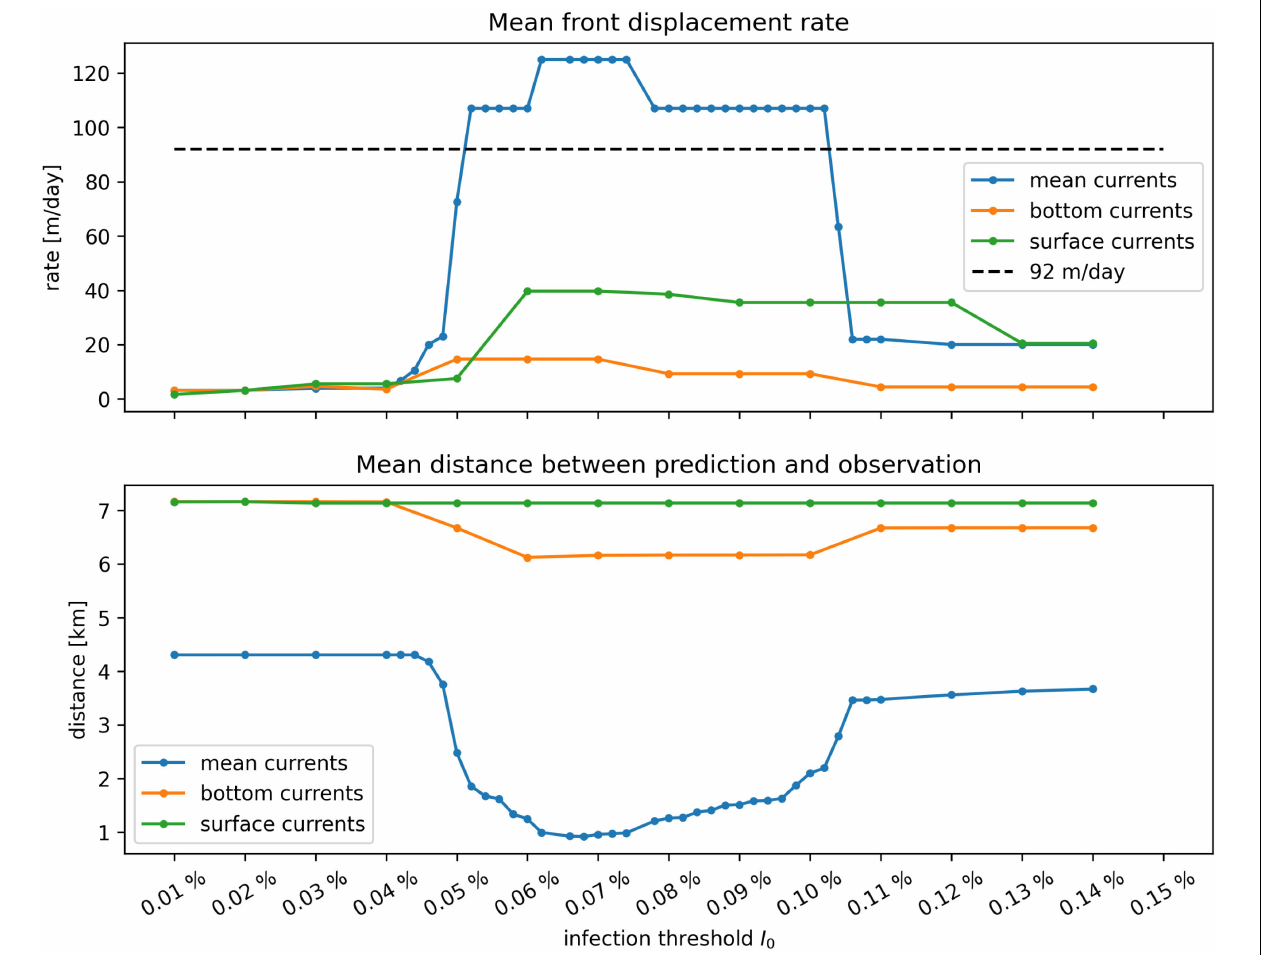
FIGURE 6 | Summary of epidemiological model simulations with calibrated transmission parameters. (Top) Modeled disease front speed for each type of current with respect to intra-reef “infection” threshold I 0 . (Bottom) Mean distance between predicted diseased reefs and observed disease points. These results show that mean barotropic currents outperformed other modes of transport at reproducing the observed spread of the disease. The appearance of a plateau suggests that the modeled spread of the disease occurs for a well-defined range of values of I 0